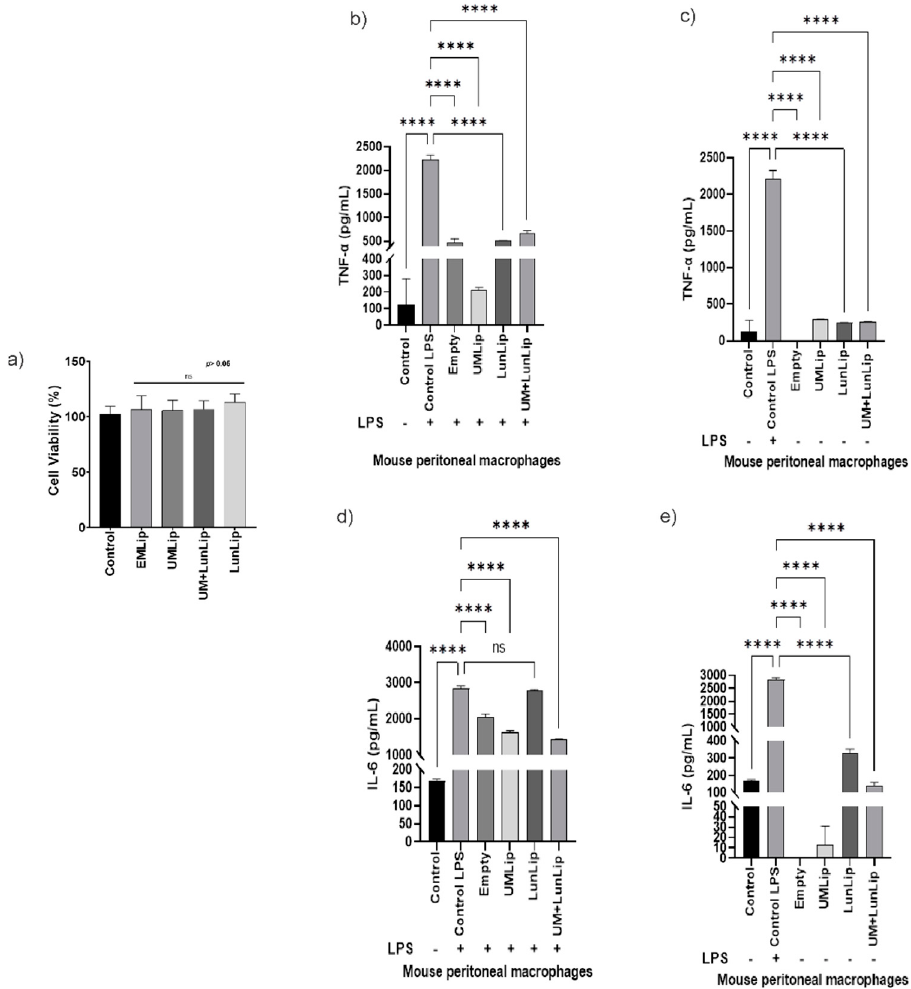
Figure 3. Liposomes prepared with dioleoyl phosphatidylcholine and dioleoyl phosphatidylglycerol, and loaded with soybean lunasin and amaranth unsaponifiable matter (UM + LipLun) decreased TNF- α and IL-6 production after LPS stimulation of peritoneal macrophages. ( a ) Cell viability of peritoneal macrophages after treatment with empty liposomes (EmLip), unsaponifiable matter-loaded liposomes (UMLip), lunasin-loaded liposomes (LunLip), and UM + LunLip. ( b ) TNF- α expression after treatment with liposomes to LPS-stimulated peritoneal macrophages. ( c ) TNF- α expression after treatment with liposomes to non-LPS-stimulated peritoneal macrophages. ( d ) IL-6 expression after treatment with liposomes to LPS-stimulated peritoneal macrophages. ( e ) IL-6 expression after treatment with liposomes to non-LPS-stimulated peritoneal macrophages. All the treatments consisted of 2 mg lunasin/mL or its equivalent in UMLip and EmLip **** p < 0.0001. ns, not statistically different.